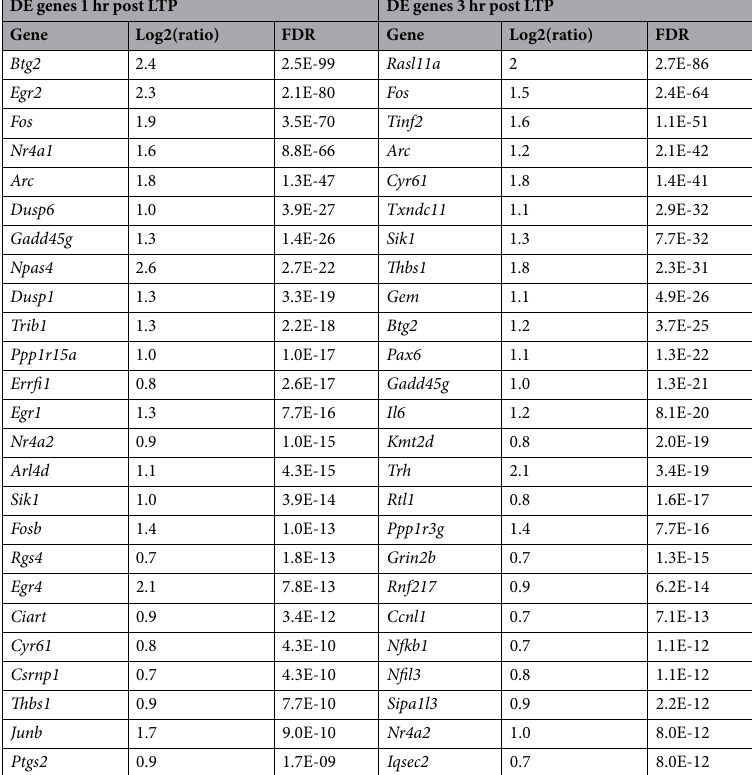
Table 1. Top 25 differentially expressed (DE) genes at 1 hr and 3 hr post LTP induction. Log 2 (ratio) and FDR (DESeq). FDR was based on multiple testing adjustment using the Benjamini-Hochberg method.